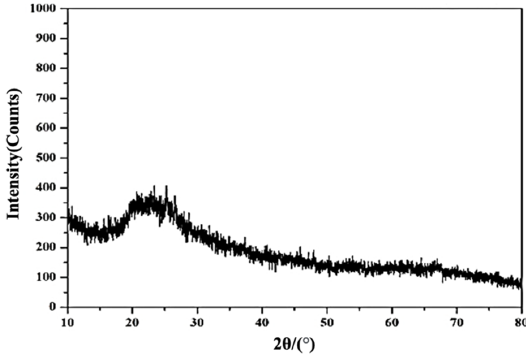
Figure 1. XRD result of metakaolin.